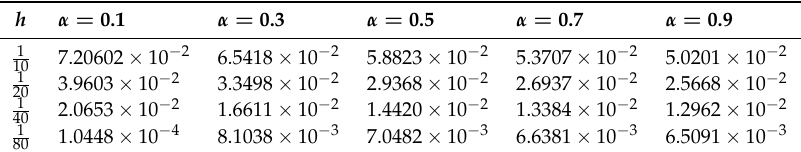
Table 4. Absolute error of Example 4 at t =